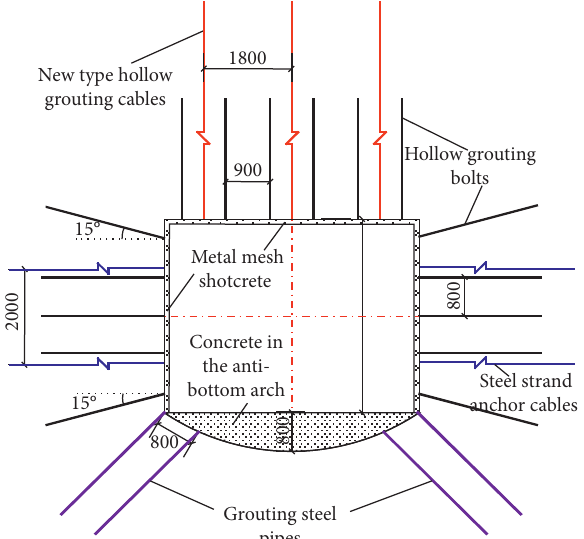
Figure 11: “Grouting+ anchor cable mesh+bottom arch” combined support scheme for weakly cemented and soft rock in the